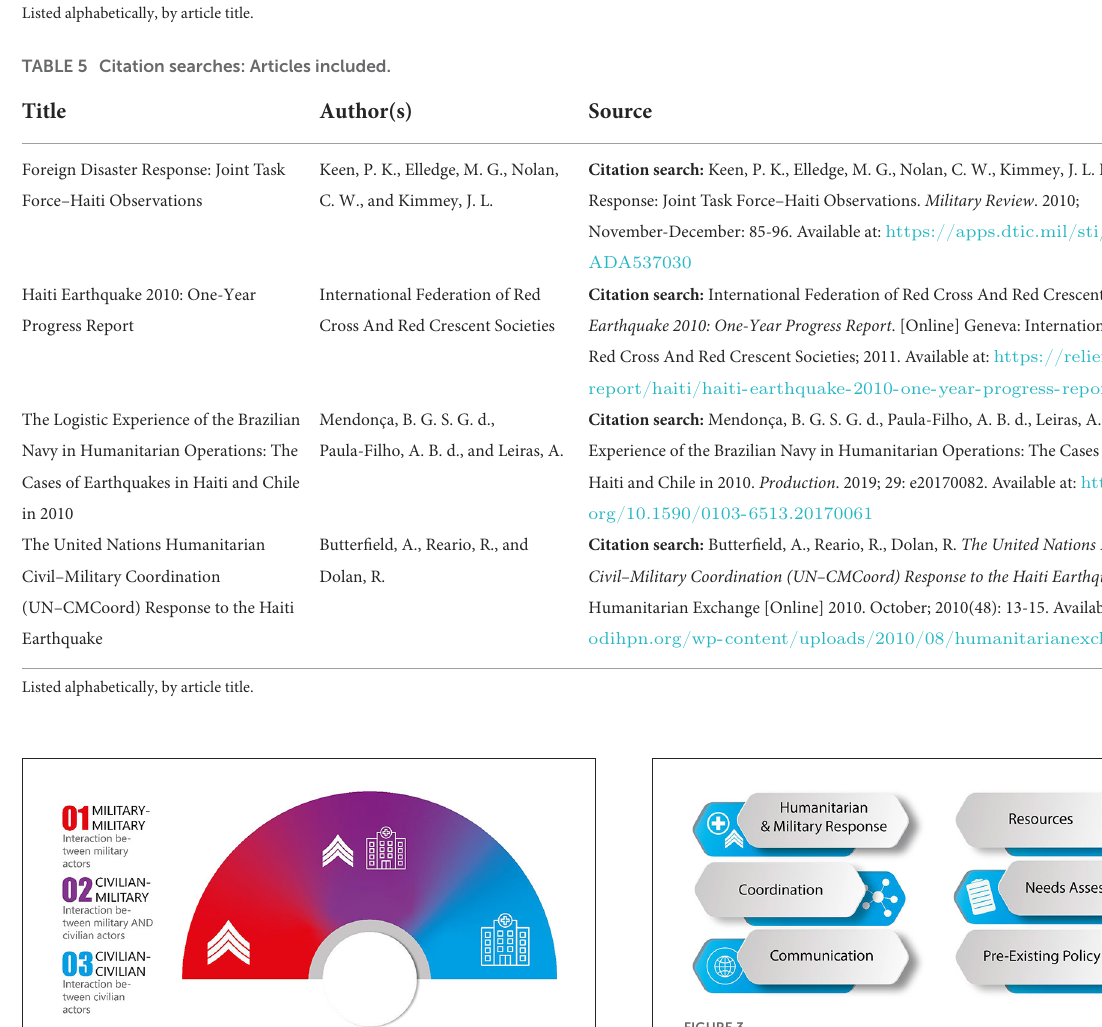
FIGURE3 Priority